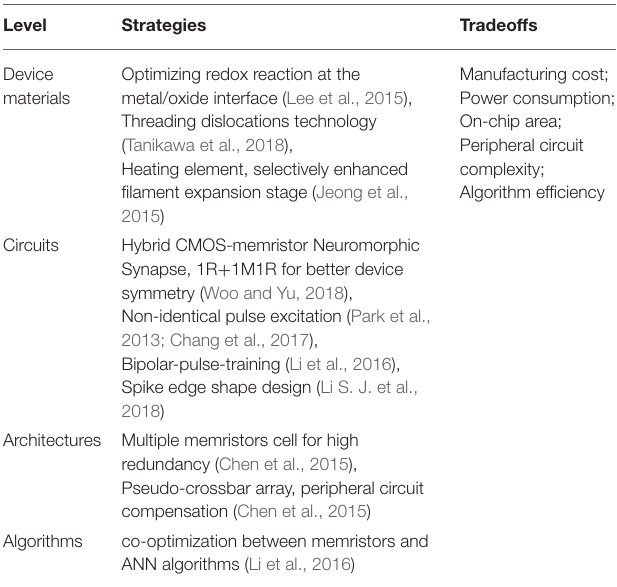
TABLE 4 | ANNs learning accuracy improvement by mitigating memristor non-ideal